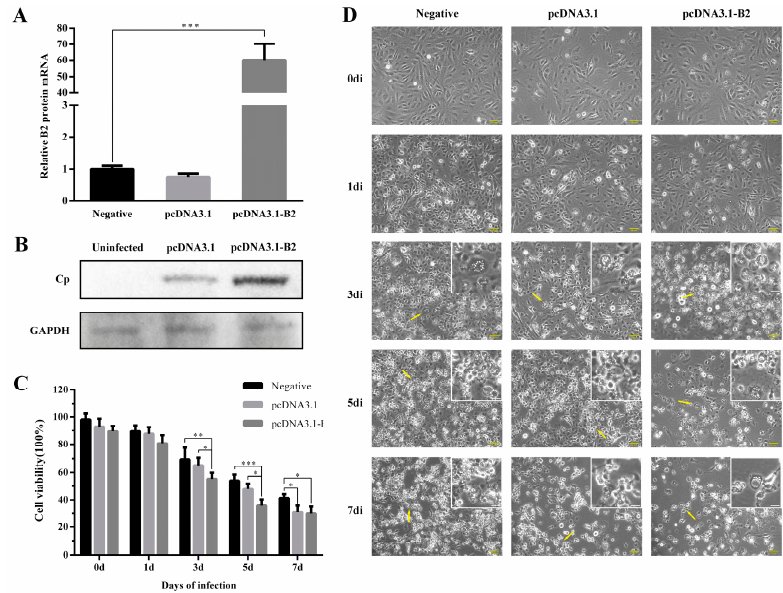
Figure 8. Overexpression of B2 protein on GF-1 cells following NNV infection. ( A ) The transfection efficiency of pcDNA3.1-B2 in GF-1 cells. *** p < 0.001. ( B ) Overexpression of B2 protein enhanced